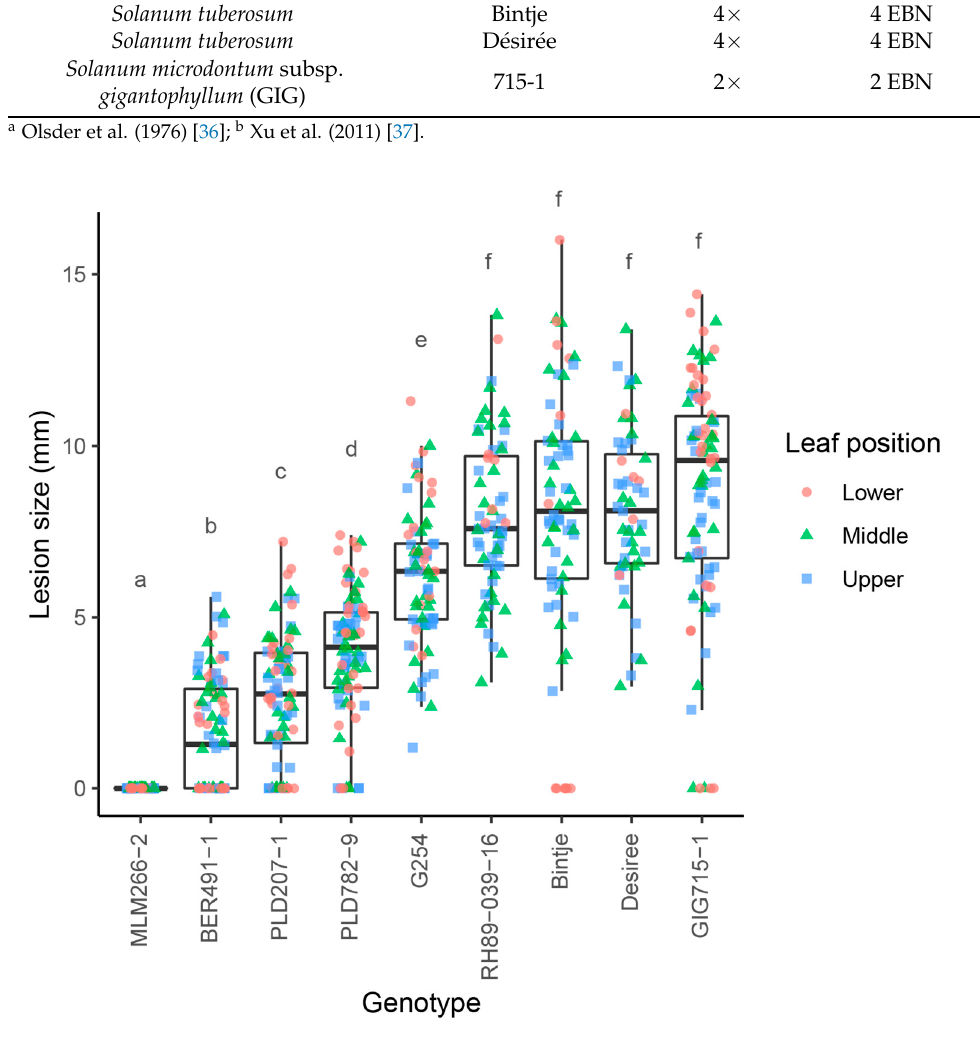
Figure 1. Genotypes with promising levels of resistance to early blight are identified in wild Solanum germplasm. Solanum genotypes (Table 1) were inoculated with Alternaria solani isolate altNL03003 and lesion diameters were measured 5 days post inoculation. Lesion sizes are visualised with boxplots, with horizonal lines indicating median values and individual measurements of lower (red), middle (green) and upper (blue) leaves plotted separately in the figure. Different letters are used to indicate significant differences between the lesions of different genotypes (Tukey’s HSD test, α = 0.05).